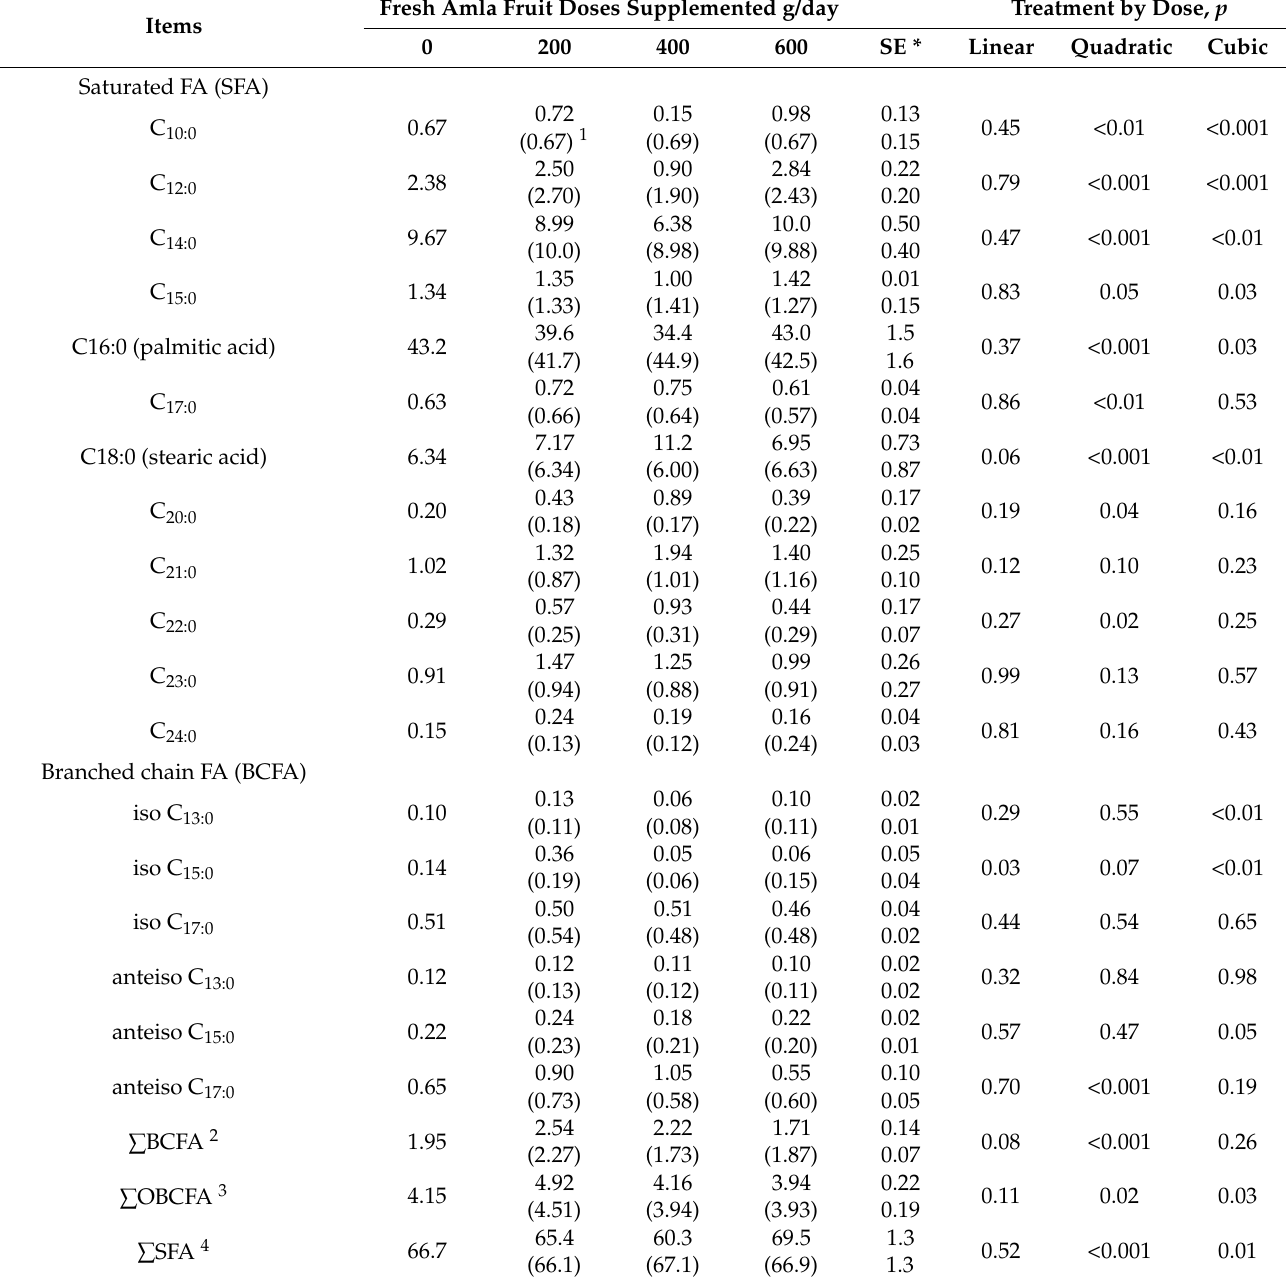
Table 4. Milk FA 1 profile (g/100 g of total fatty acids) of lactating cows fed a TMR without